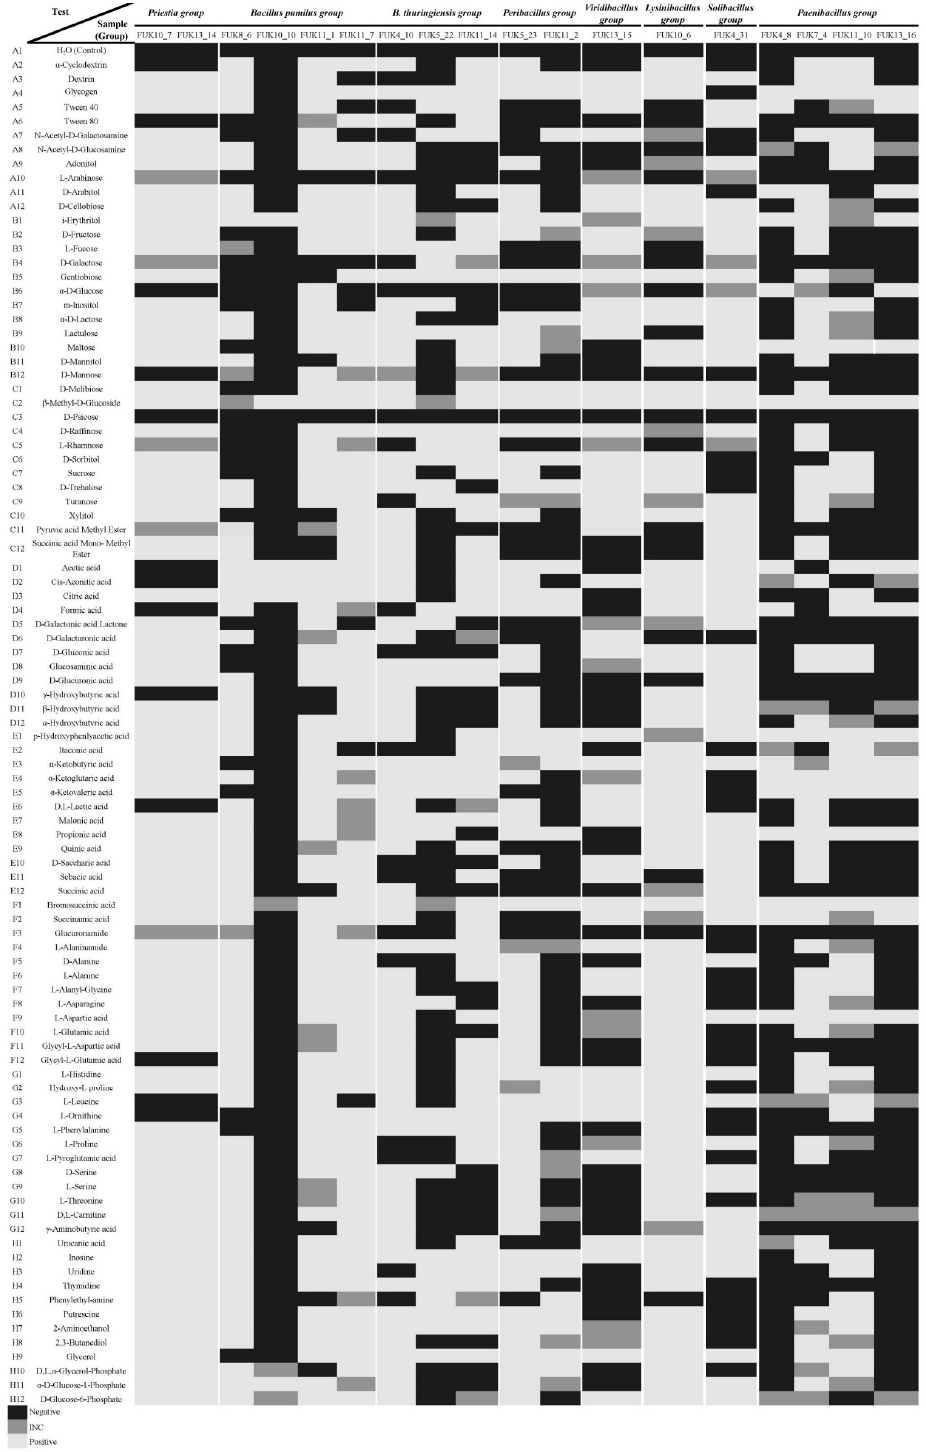
Figure 4. Mapping of metabolic fingerprint of SF-bacteria from Fukushima. It was obtained by excel commanding from raw reads after 24 h, 48 h, and 72 h incubation. ■ indicates those results were negative, (cid:4) indicate those inconclusive results (INC), and (cid:4) indicates the positive reaction from SFM